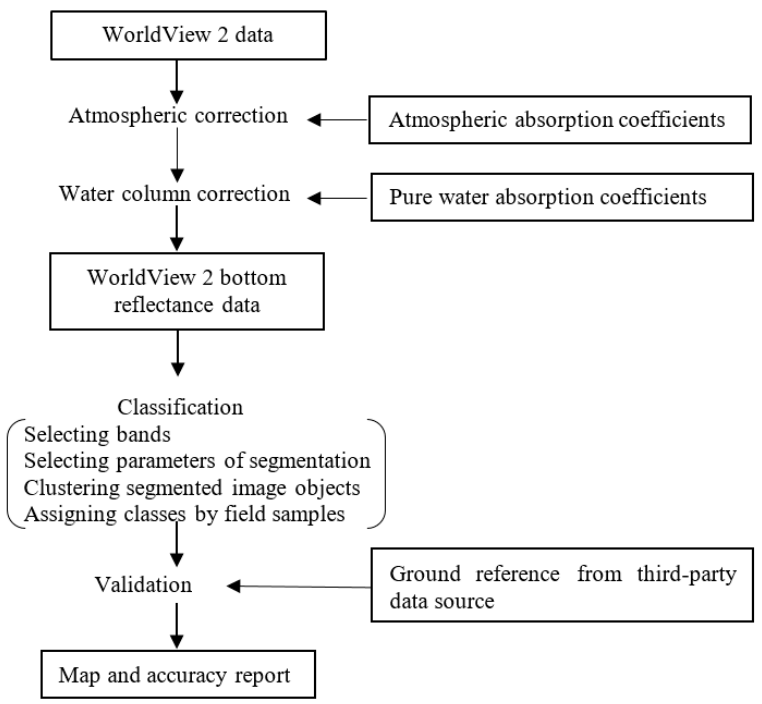
Figure 2. The workflow of the data processing and classification.